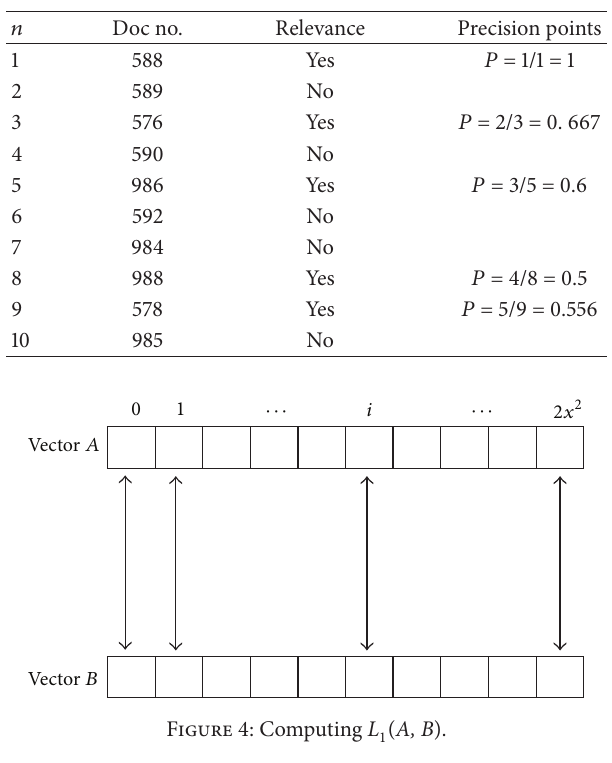
Table 6: Example of average precision calculation.